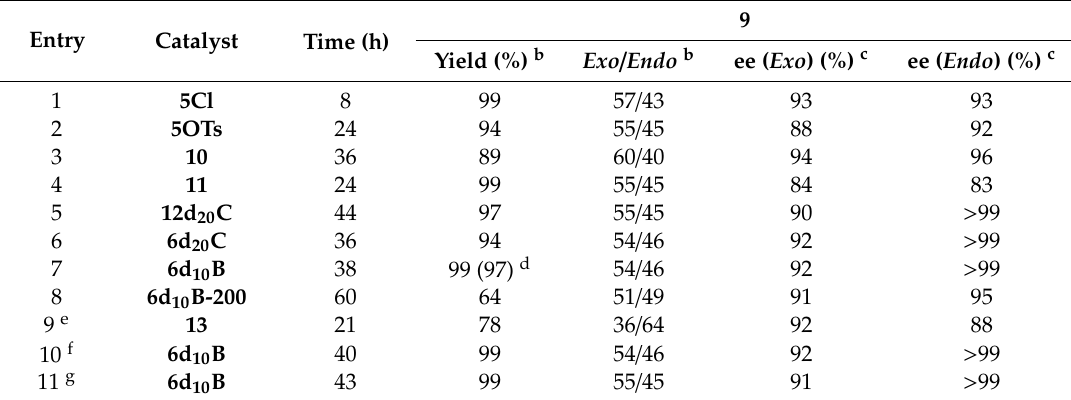
Table 4. Catalyst comparison in the asymmetric DA reaction a .